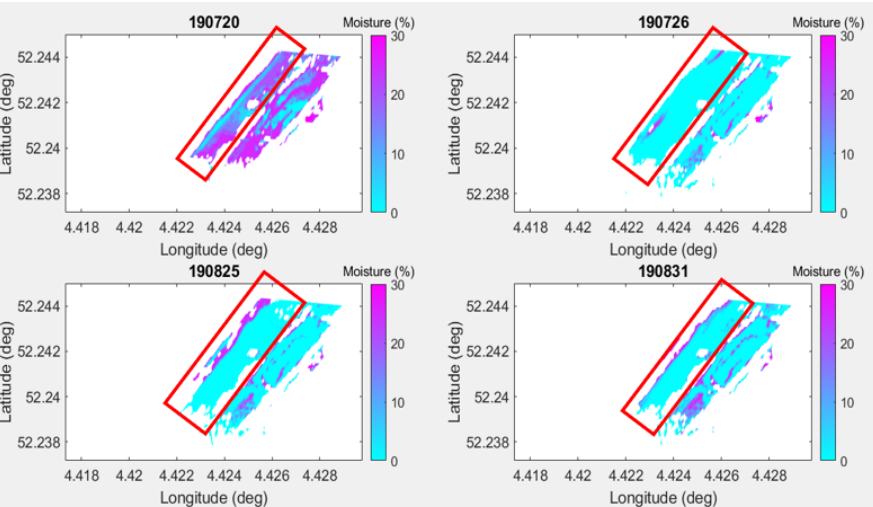
Figure 9. Moisture map of the area scanned by the laser on 20 July 2019, 26 July 2019, 25 July 2019, and 31August 2019 at 8:00 a.m. The beach areas are shown in the red rectangles, with different widths depending on the tide. The back and foredune areas (right bottom) and the shadows of the dunes (with no cloud points) are included in the present maps, but their moisture was not investigated. The turquoise color in the beach areas indicates a low surface moisture content. Toward the sea, the surface moisture increases, reaching a saturation of 30%. This does not occur in the image evaluated on 20 July 2019.